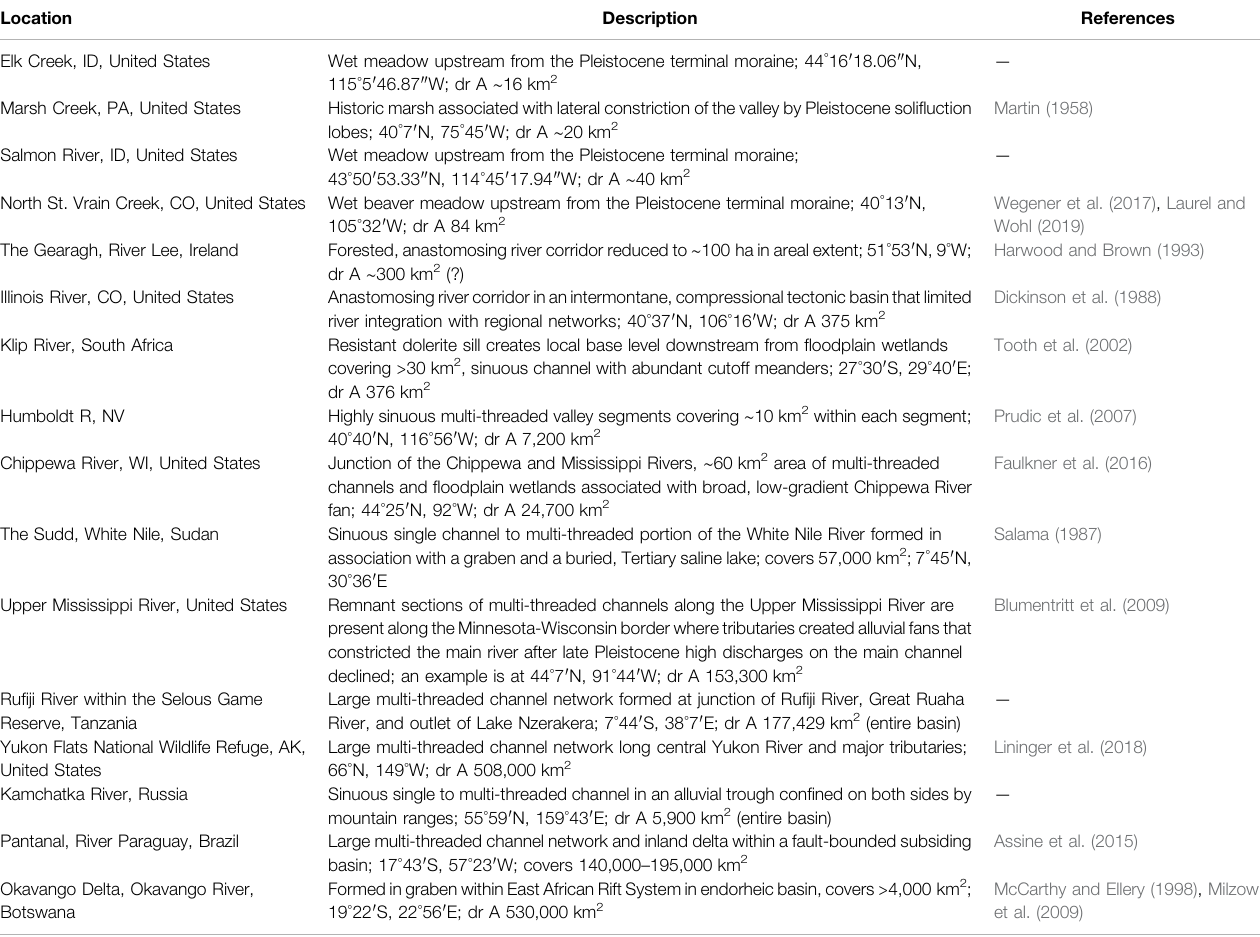
TABLE 1 | Contemporary examples of remaining river-wetland corridors.